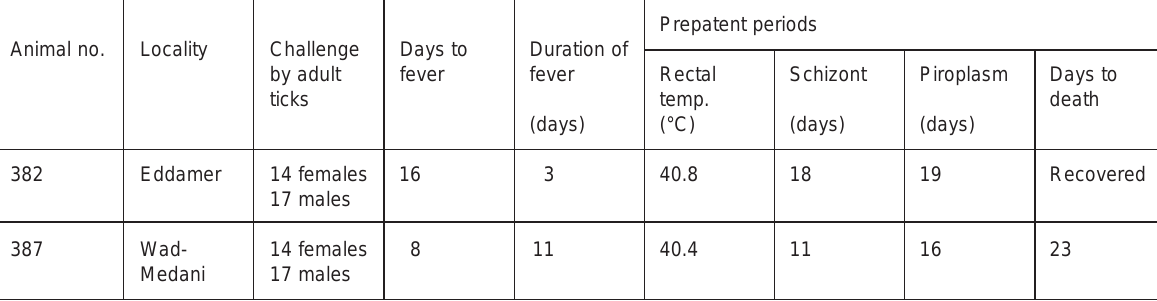
Prepatent periods